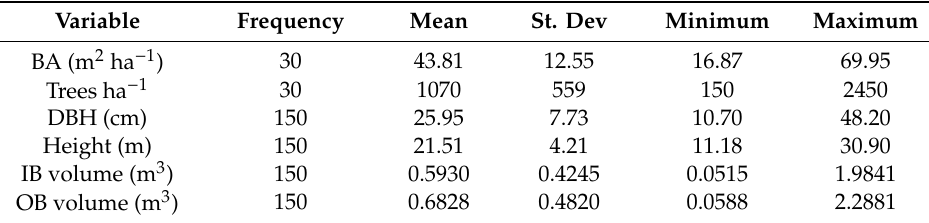
Figure 1. Distribution of red pine plantation plots sampled across Ontario, Canada. Table 1. Summary statistics for measured characteristics of plantation grown red pine trees from Ontario used in this study. BA = basal area per ha; trees ha − 1 = density; DBH = diameter at breast height; height = total height; IB = inside bark; OB = outside bark.